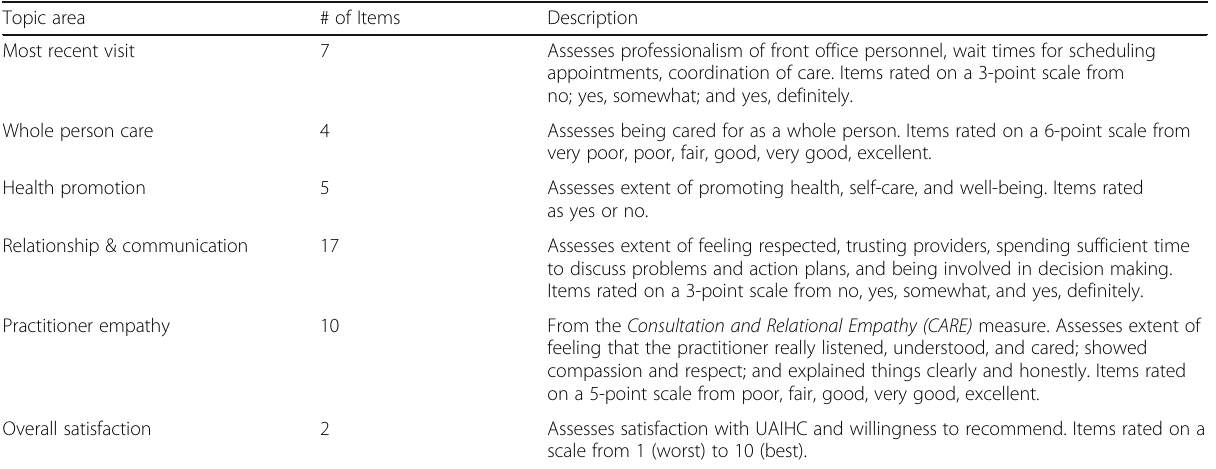
Table 1 Patient experience questionnaire Topic area # of Items Description